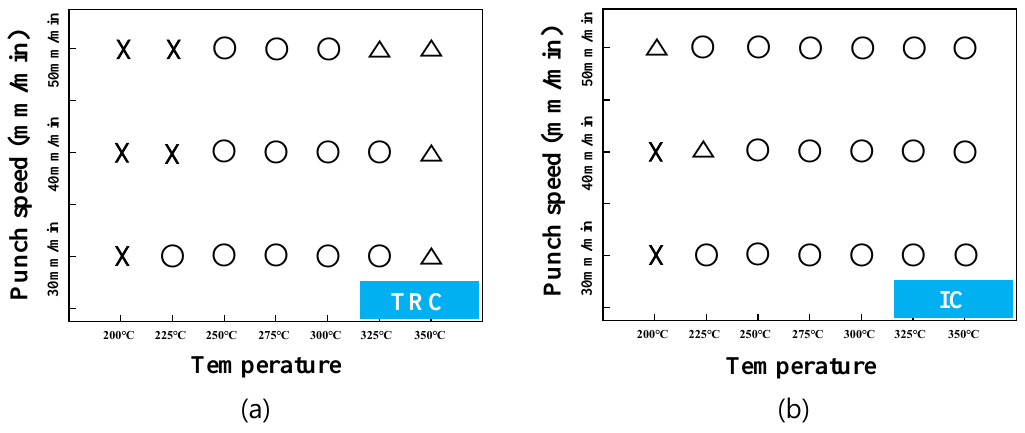
Figure 6. Deep drawability of Mg–Al–Mn sheets at various temperatures and deformation rates. × : failed, (cid:13) : succeeded, (cid:52) : wrinkled. ( a ) TRC, ( b ) IC.